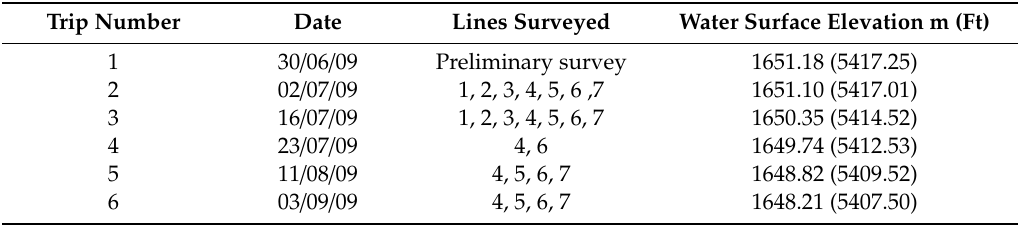
Table 2. Sonar survey schedule for DCR showing the date of the survey trip, the lines that were surveyed, and the elevation of the reservoir surface obtained from the Bureau of Reclamation who operates the